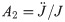
Role of population heterogeneity for the behavior of the generalized SIR model.Plots of various dimensionless ratios of parameters characterizing the shape of the infection wave for different values of α. Here the limit α → ∞ corresponds to the homogeneous SIR model, the limit α → 0 to the strongly heterogeneous case. Here λ0 and λ∞ denote the initial and final growth rate, A2=J¨/J and A3=J⃛/J describe the shape of the wave at the maximum of new cases per day J. The horizontal dashed lines correspond to estimates from fits shown in Fig 3, the shaded regions indicate uncertainty ranges, see Appendix D.